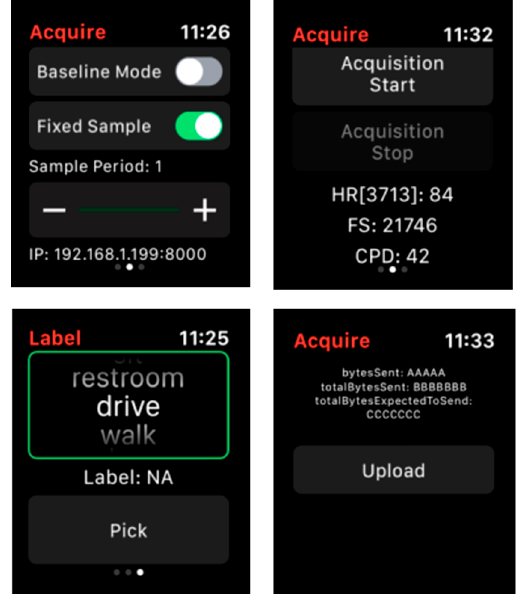
Figure 5. Screenshots of the CPAM app. These functionalities allow the user to ( top left ) specify the sampling rate, ( top right ) start and stop data acquisition, ( bottom left ) provide a label for the current activity, and ( bottom right ) send collected and labeled data to a server.